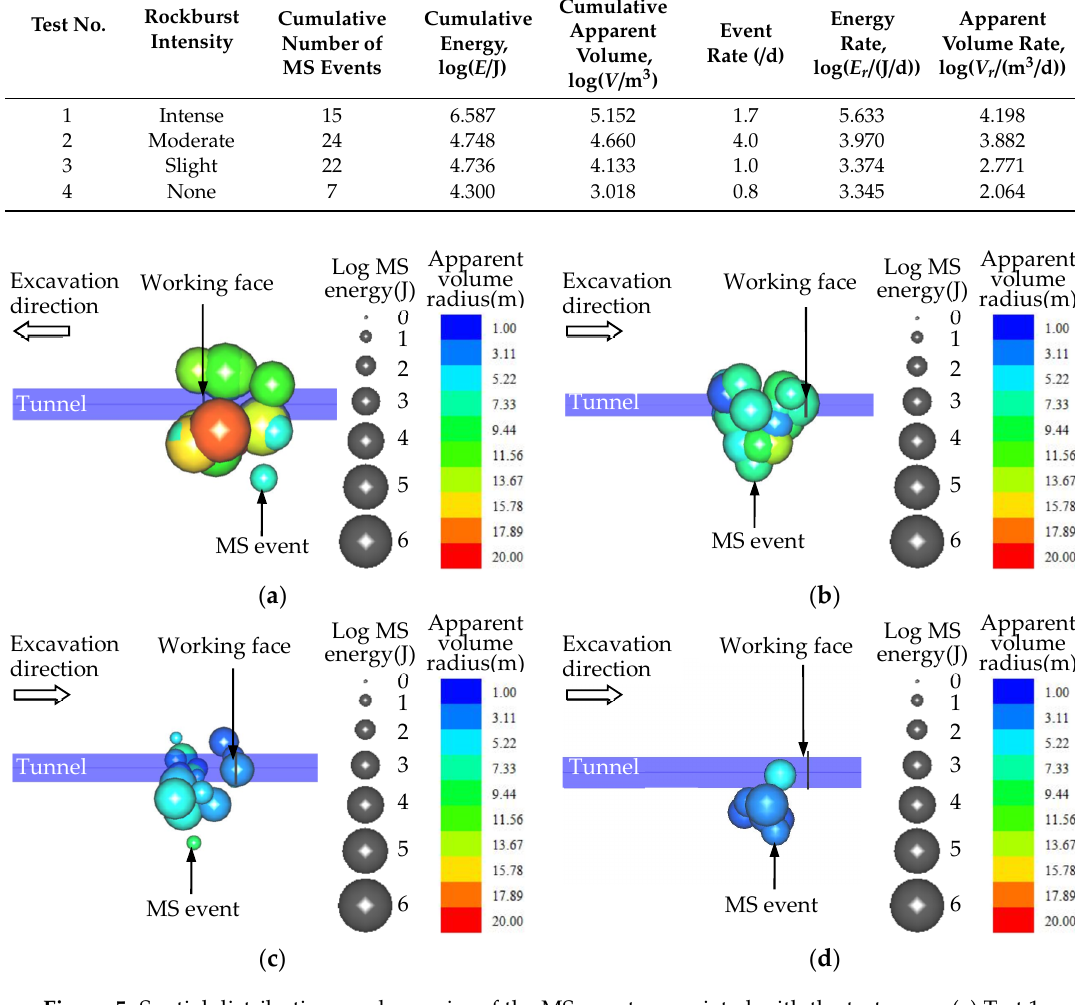
Figure 5. Spatial distributions and energies of the MS events associated with the test cases: ( a ) Test 1; ( b ) Test 2; ( c ) Test 3; ( d ) Test 4.